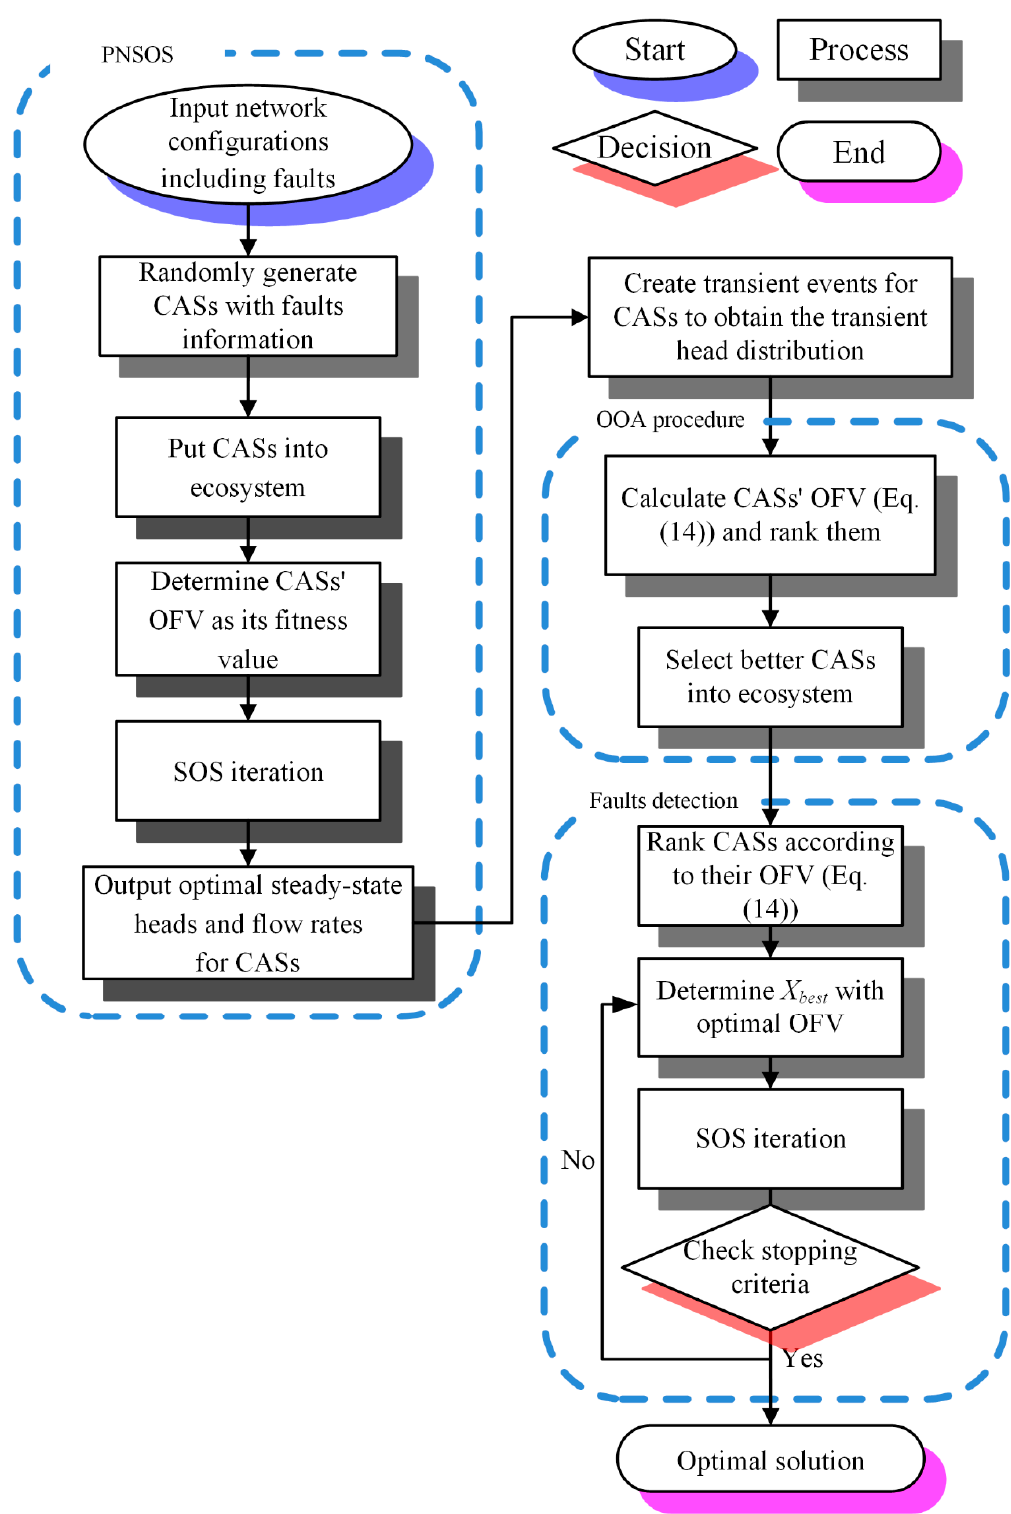
Figure 1. Flowchart of the Pipe Examination Ordinal Symbiotic Organism Search (PEOS).